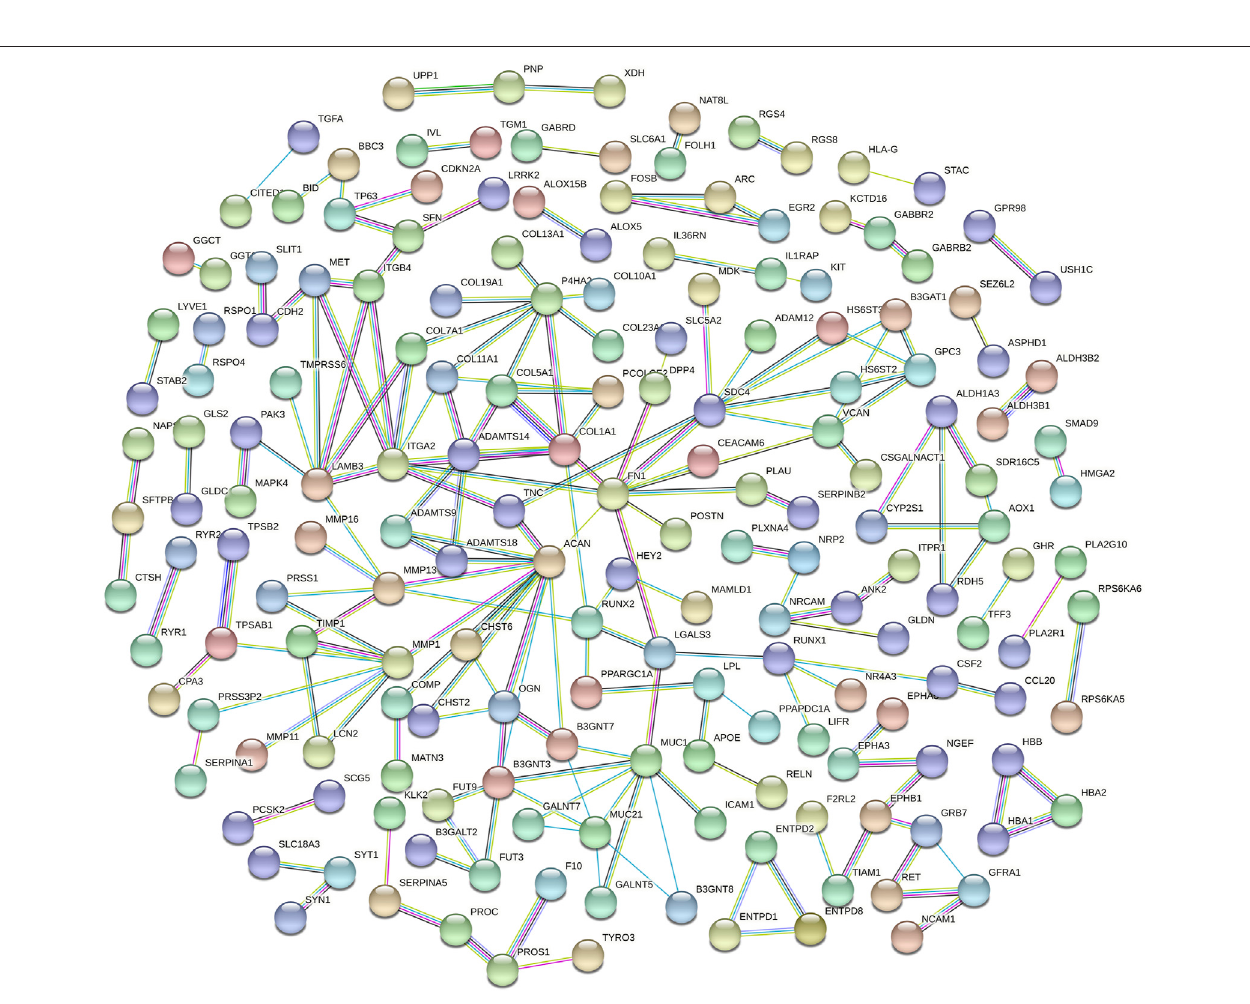
FIGURE 7 | The PPI networks of DE